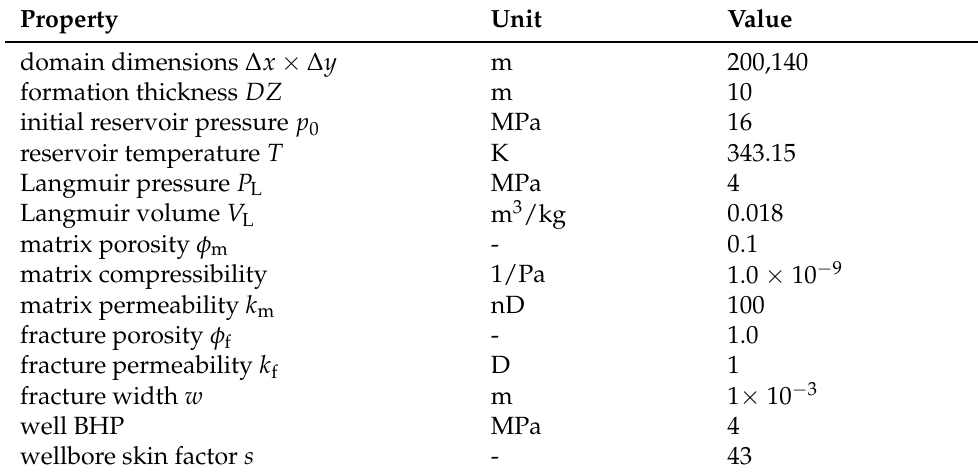
Table 4. Key reservoir and simulation parameters of